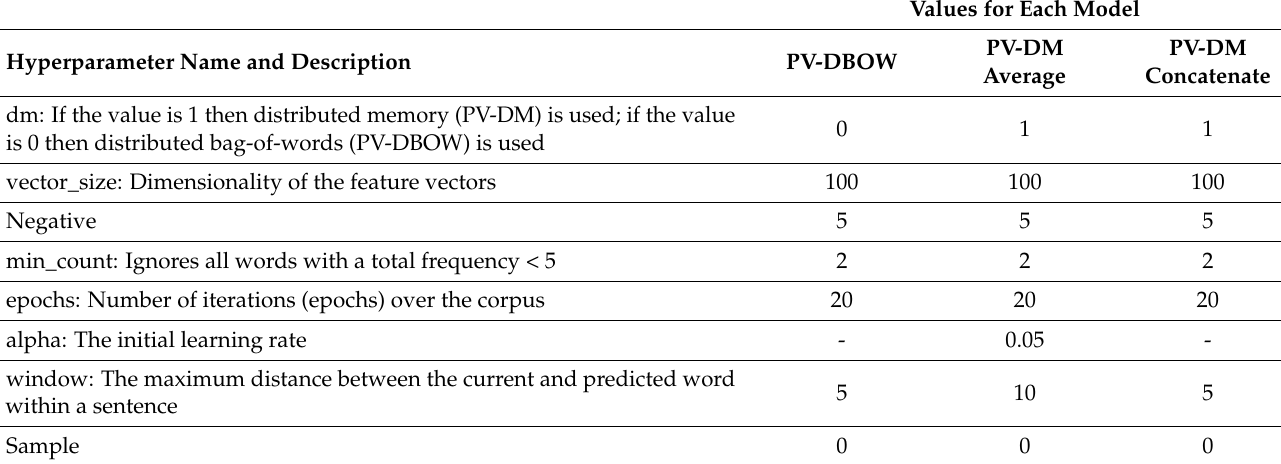
Values for Each